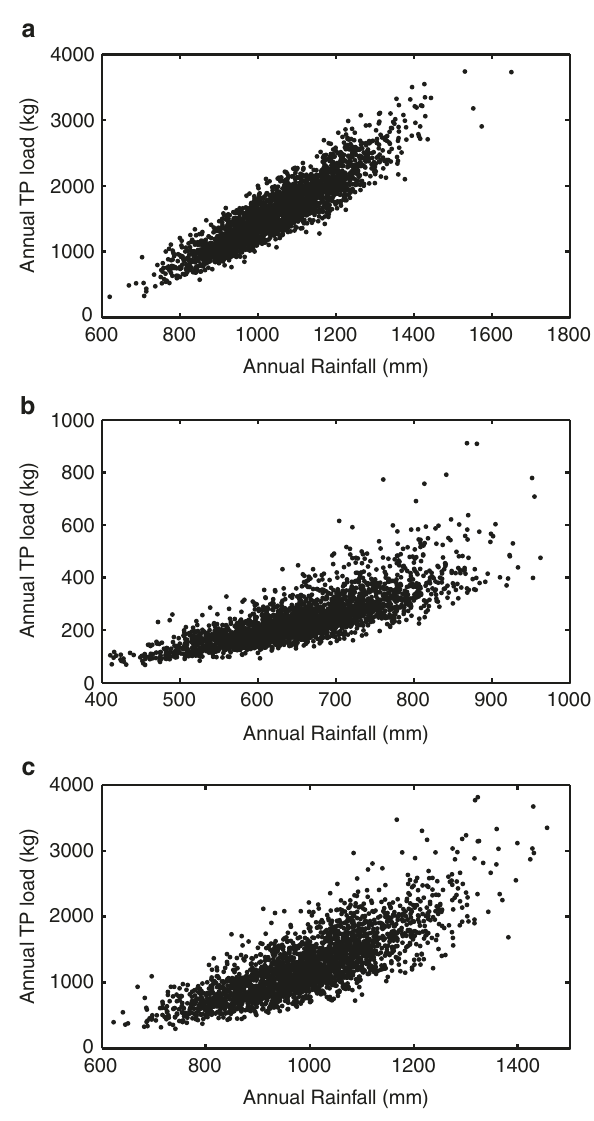
Fig. 1 The relationship between annual total phosphorus load and rainfall in three UK catchments. Annual total phosphorus (TP) load and rainfall are from one behavioural parameter set in the Hydrological Predictions for the Environment (HYPE) model, for years 5 – 30 from 100 runs of baseline conditions for a Newby catchment, Eden ( R 2 = 0.82, p < 0.01), b Blackwater catchment, Wensum ( R 2 = 0.61, p < 0.01) and c Wylye catchment, Avon ( R 2 = 0.63, p < 0.01). The dominant driver of annual P load is annual